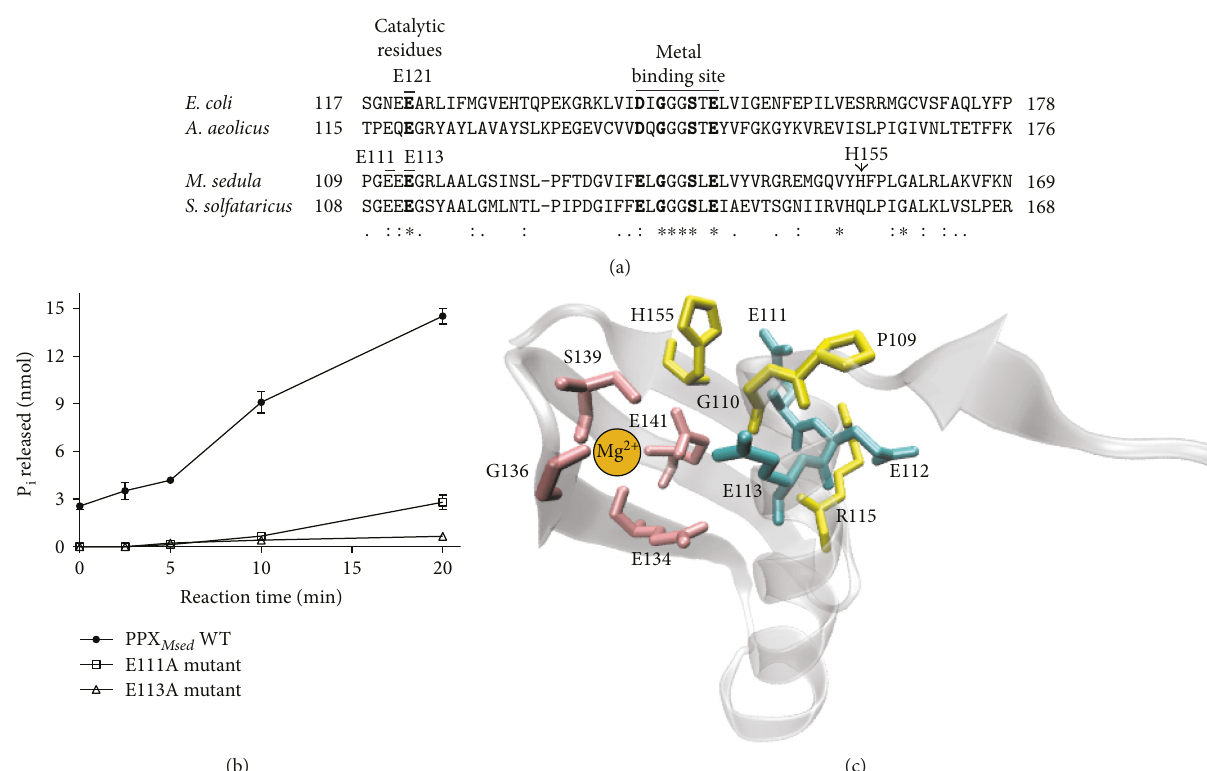
Figure 3: Catalytic residues of the possible active site of PPX . (a) Protein sequence alignment of the residues in the potential active site of Msed M. sedula , S. solfataricus , A. aeolicus , and E. coli PPXs. The residues that have been proven essential for catalysis in PPX bold [32, 33] (asterisk indicates fully conserved residue, colon indicates strongly similar properties, and period indicates weakly similar properties). (b) Activity of PPX and the E111A and E113A mutants. (c) Cartoon representation of the possible active site of PPX Msed Amino acids in the metal binding site are shown in pink, the mutated residues are shown in cyan, and residues near E111 are shown in yellow.